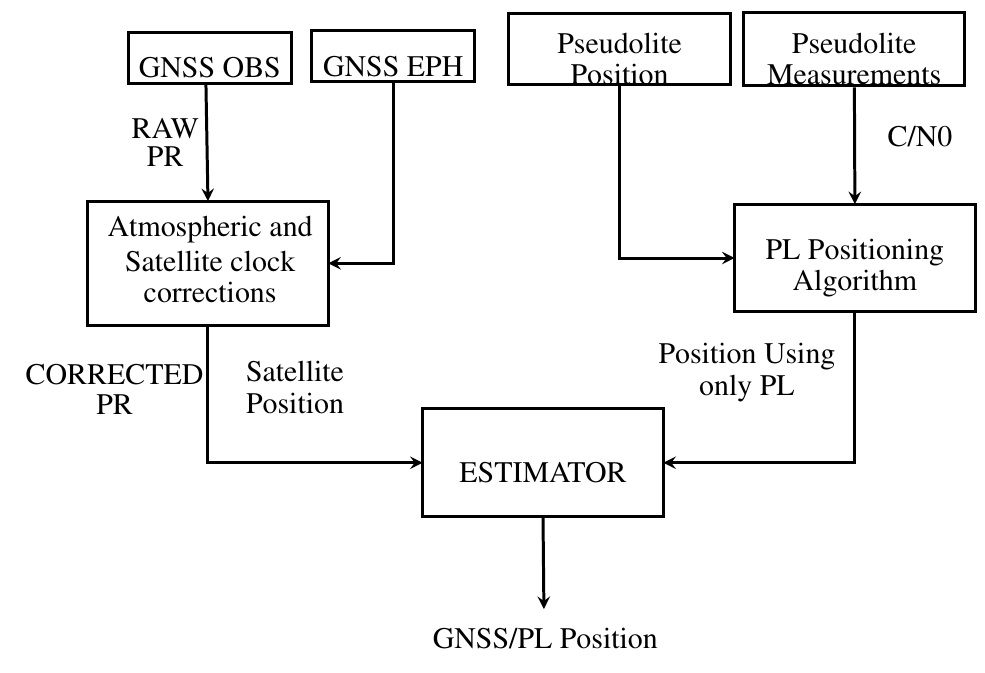
Figure 1. Loosely-coupled integration flow